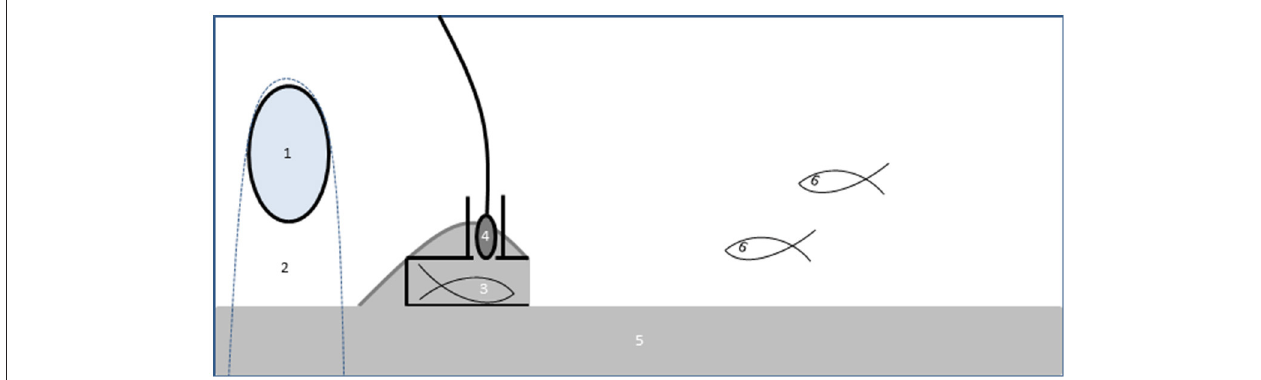
FIGURE 1 | Schematic overview of the experimental set-up in an experiment to test effects of noise on multimodal communication in the Painted Goby. A noise-egg (1) was placed in a cloth with sand as weight (2) behind the male’s nest (3). A hydrophone in the nest chimney (4) recorded male sounds. Aquaria contained a layer of sand (5) on the bottom, which males used to build a nest over the provided PVC-tube. The male and the two females (6) could interact freely during the